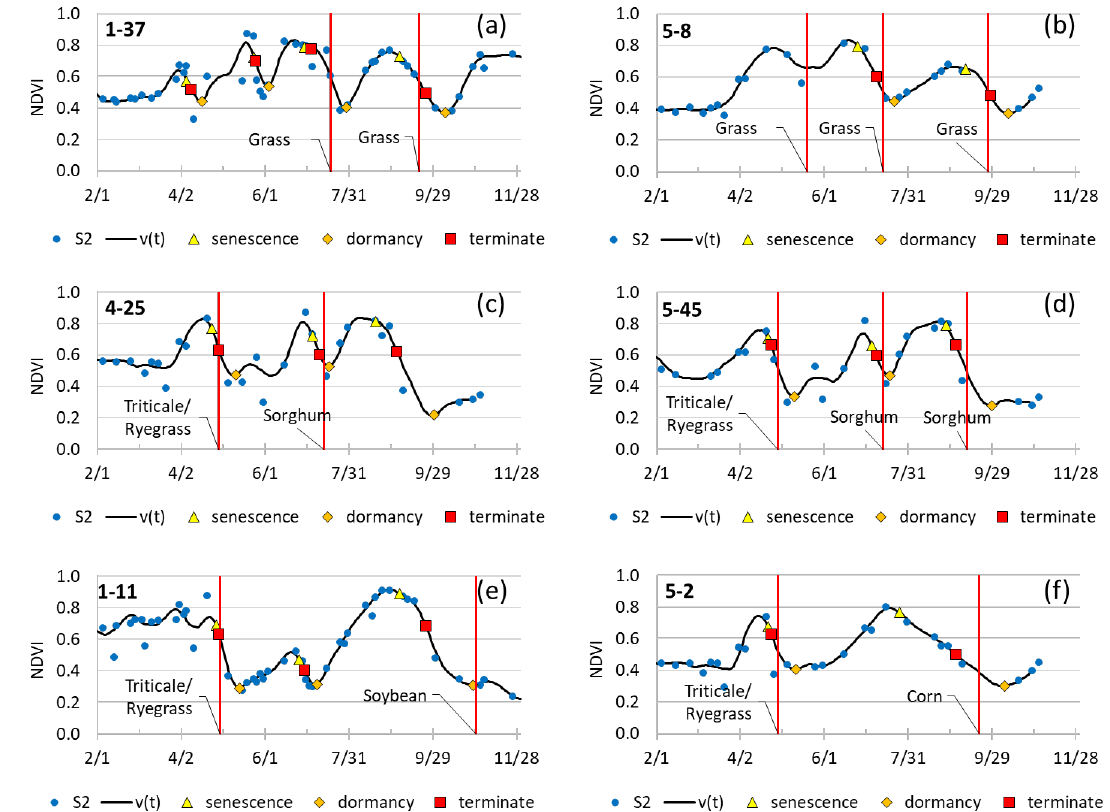
Figure 9. Detected termination dates (red squares) from the Sentinel-2 time-series and the recorded harvest operation (vertical red lines) for six typical cover crop fields (( a – f ), field name in the upper left) in BARC.